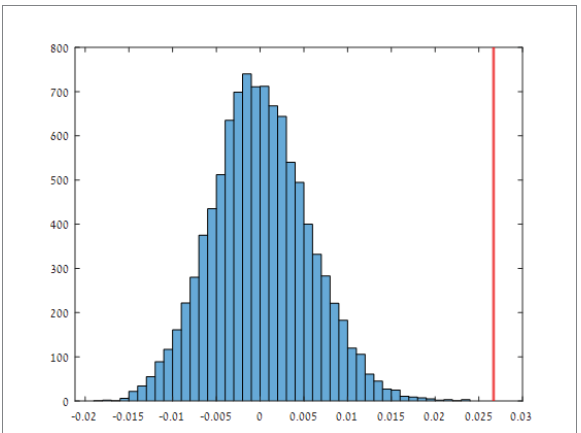
FIGURE 6 Results of analysis of similarity (ANOSIM) analysis with Euclidean distance as a dissimilarity metric between pairs of samples, generated by matrix permutation. A histogram of 10,000 random R e values is compared with the observed R o value ( R o = 0.0267; red line), using MATLAB. This indicates a highly significant effect of habitat (cave vs. surface) on the isotopic values of the samples.